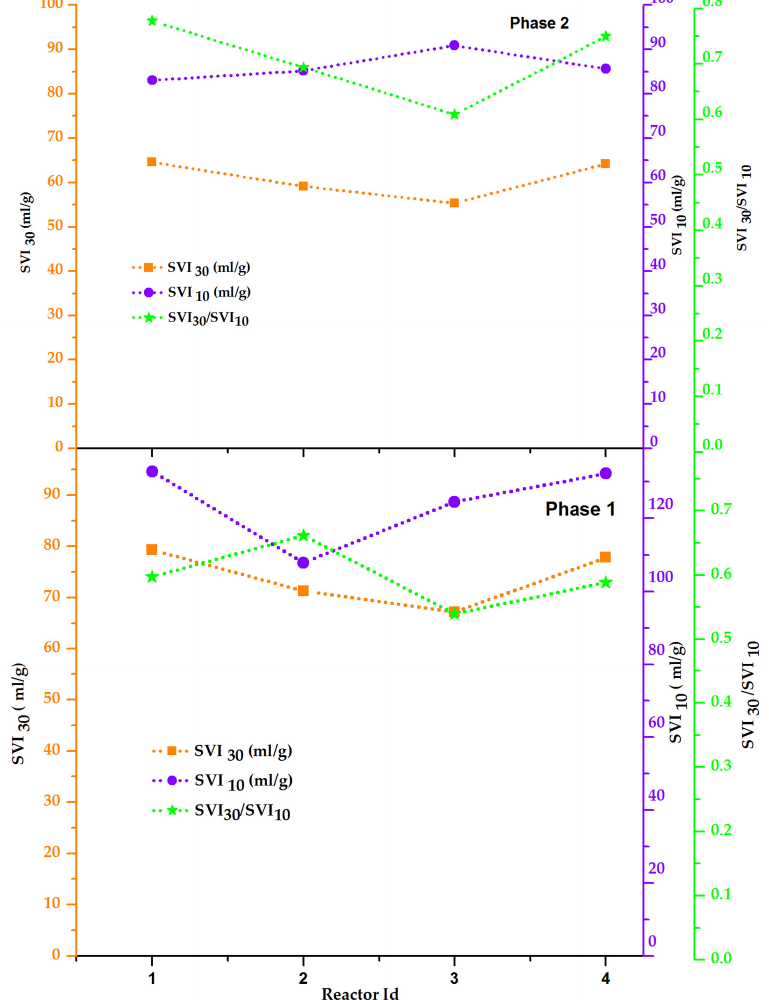
Figure 4. Sludge volume index (SVI30 and SVI 10) and SVI 30/SVI 10 ratios at two different phases (Phase 1: cycle time = 3 h; Phase 2: cycle time = 9 h).